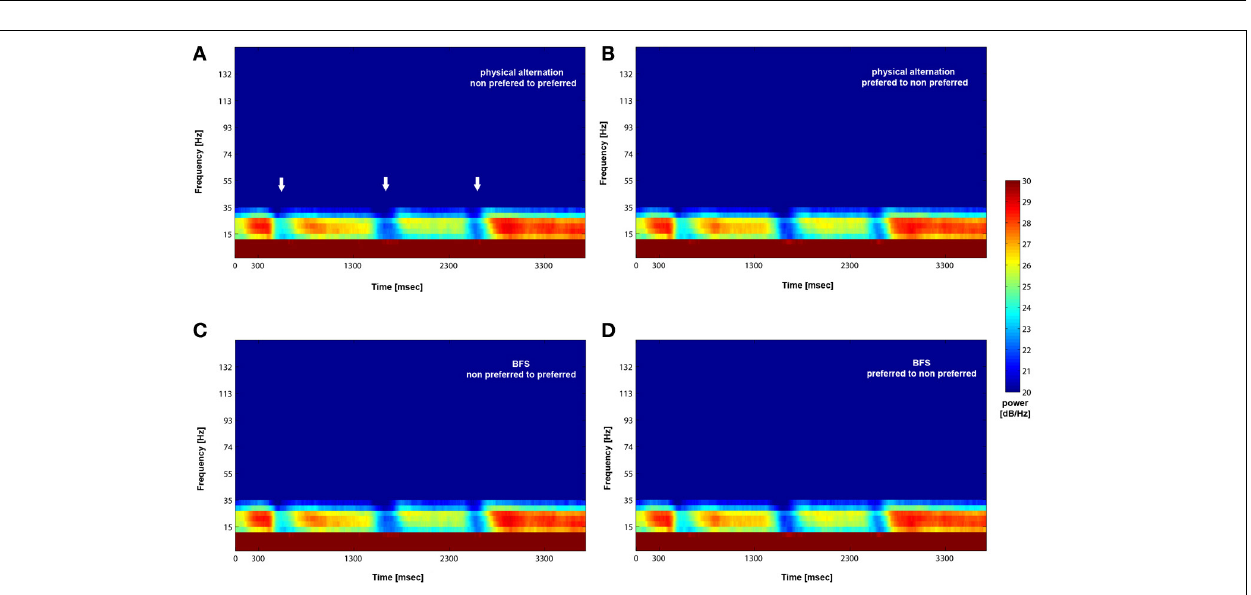
relationship to stimulus preference for both PA ( A and B ) and BFS ( C and D ). Beta oscillations are particularly prominent during the inter-trial period.